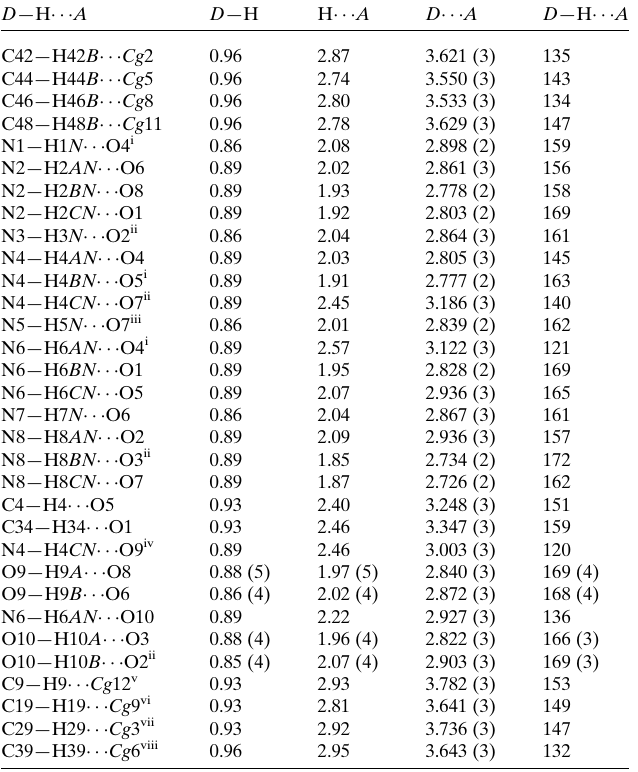
Table 1 Hydrogen-bond geometry (A˚ , (cid:4)